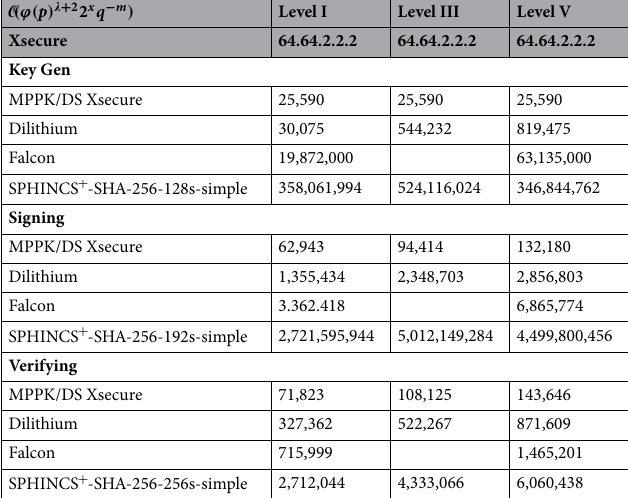
Table 5. Performance comparison of the optimized MPPK/DS Xsecure are tabulated for key generation, signing, and verifying against NIST standardized algorithms. All performance results are displayed in clock cycles. We choose SHA-256, SHA-384, and SHA-512 for MPPK/DS Xsecure security level I, III, and V respectively but only SHA-256 is selected for other standardized algorithms. That means, MPPK/DS Xsecure uses hash codes 32 bytes, 48 bytes, and 64 bytes for security level I, III, and